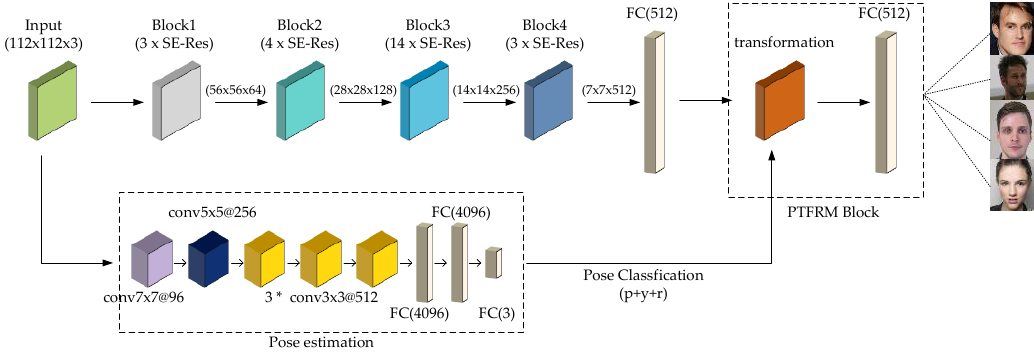
Figure 6. The overall network architecture.